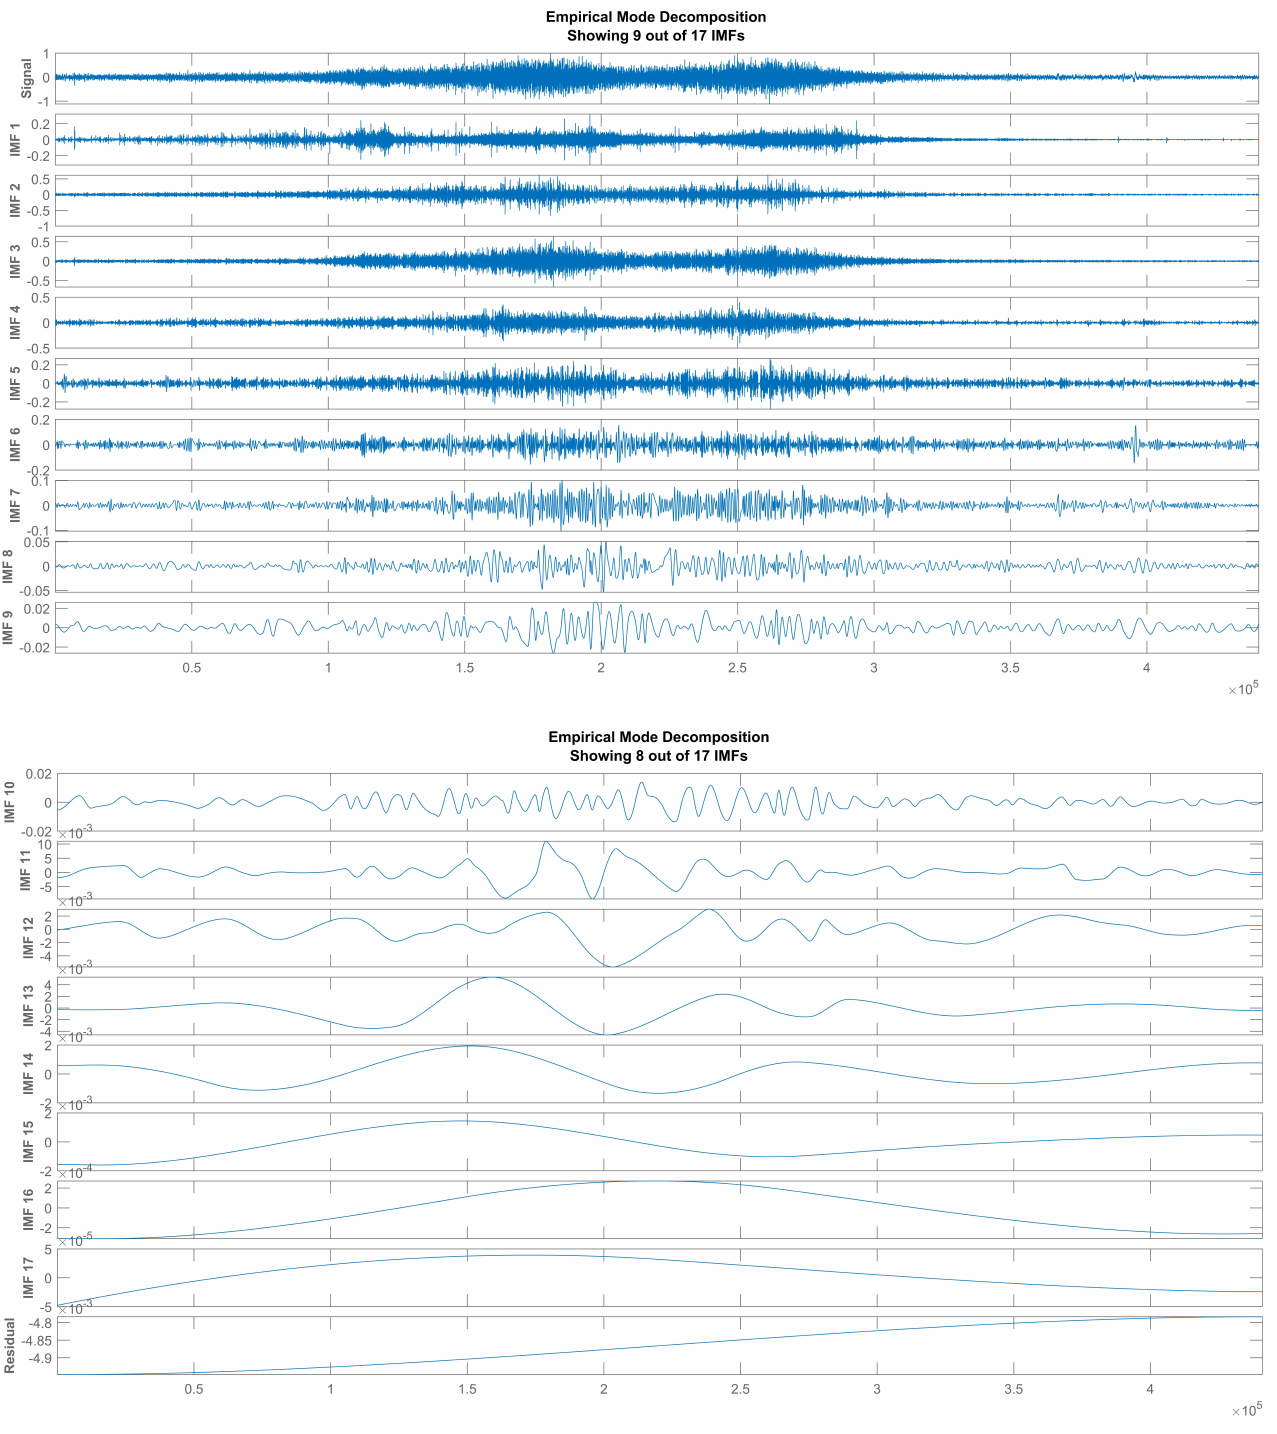
Figure 2. Empirical mode decomposition and intrinsic mode function